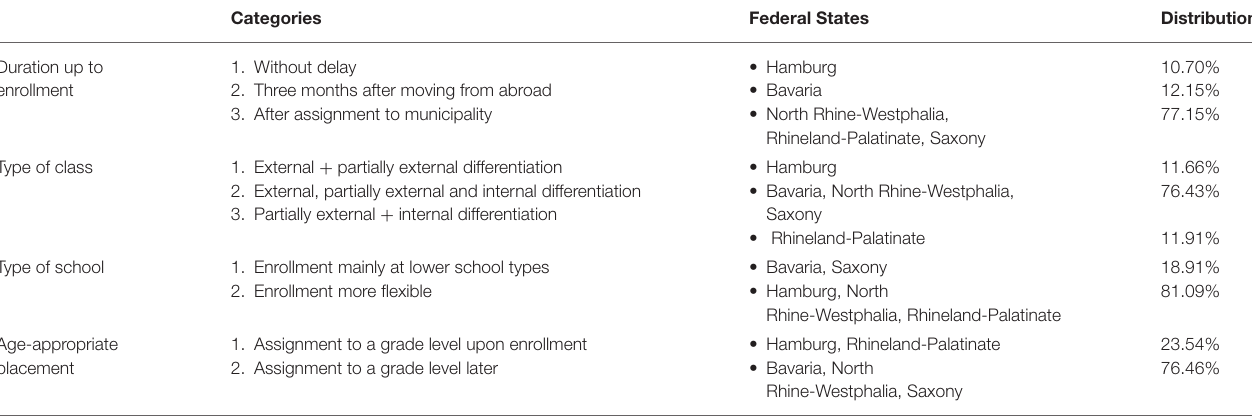
TABLE 5 | Overview of categorization of legal regulations per dependent